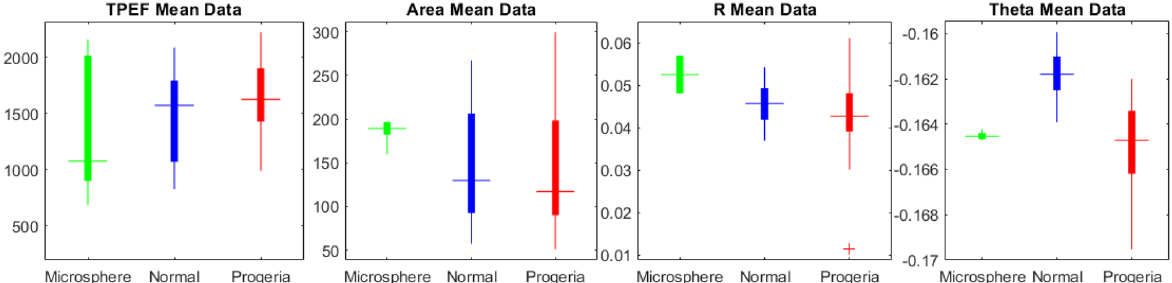
Figure 7. The statistical analysis to discrimination to indicate the sensitivity of the phasor approach. The size of the nucleus, TPEF intensities, modulation, phase mean values, then corresponding skewness and kurtosis. There is more sensitivity for phase rather than modulation as the phase is link to the retardance.